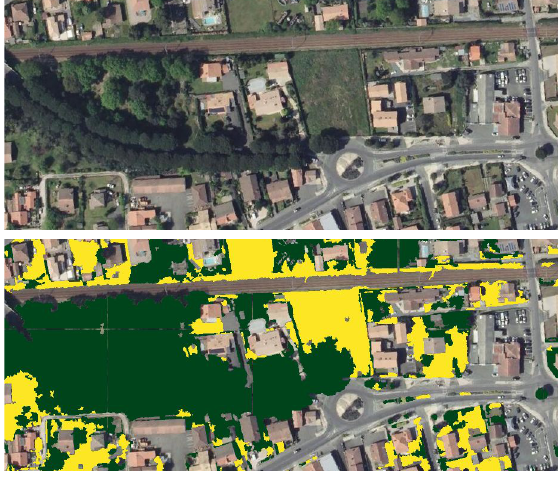
Figure 7. Example of forest (green) and grassland (yellow) ground truth generated semi-automatically